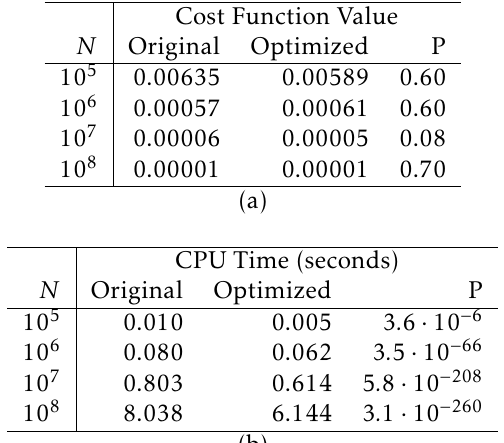
Table 4. Polynomial Root Finding: (a) optimization cost function, and (b) CPU time. Results are averages of 100 runs, and the P column shows t-test